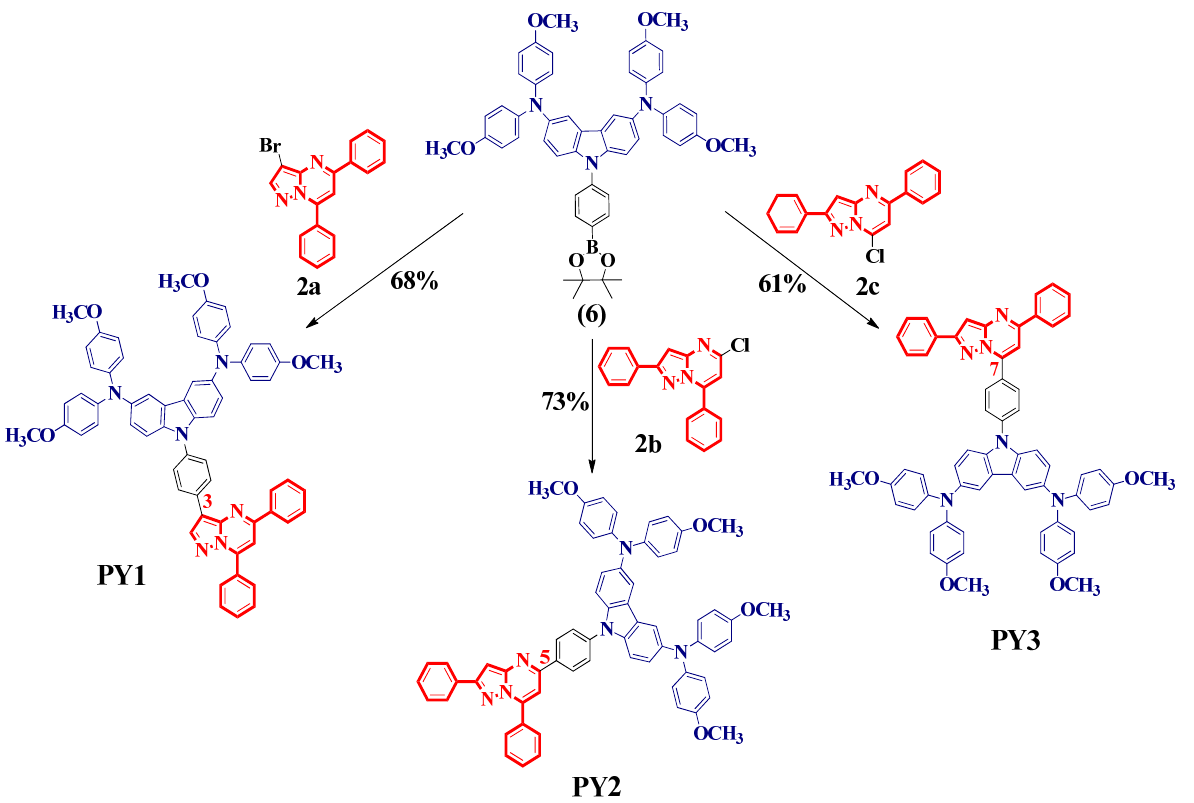
Figure 1. Synthetic route of PY1 – PY3 molecules by Suzuki–Miyaura cross-coupling reaction. Reagents and conditions: 2a – c (1 equiv), compound 6 (1.1 equiv), PddppfCl 2 (0.1 equiv), Na 2 CO 3 (5 equiv), 1,4-dioxane/water (5:1) under MW irradiation at 110 °C for 2 h.